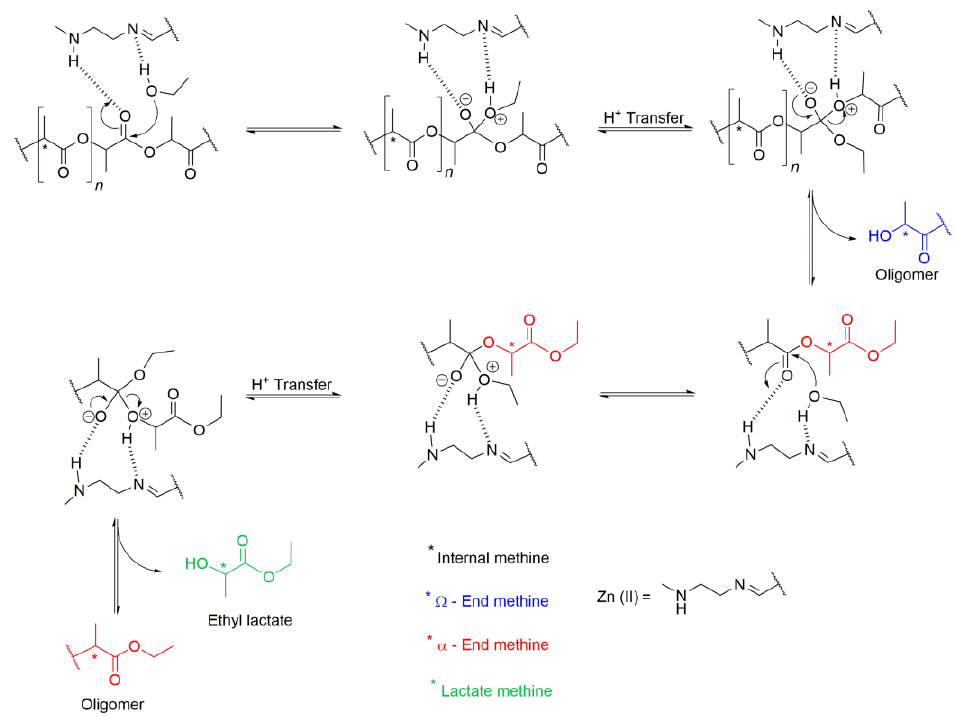
Figure 5. Proposed mechanism for transesterification reaction of PLA using ethanol and Zn ( 1 ) 2 .